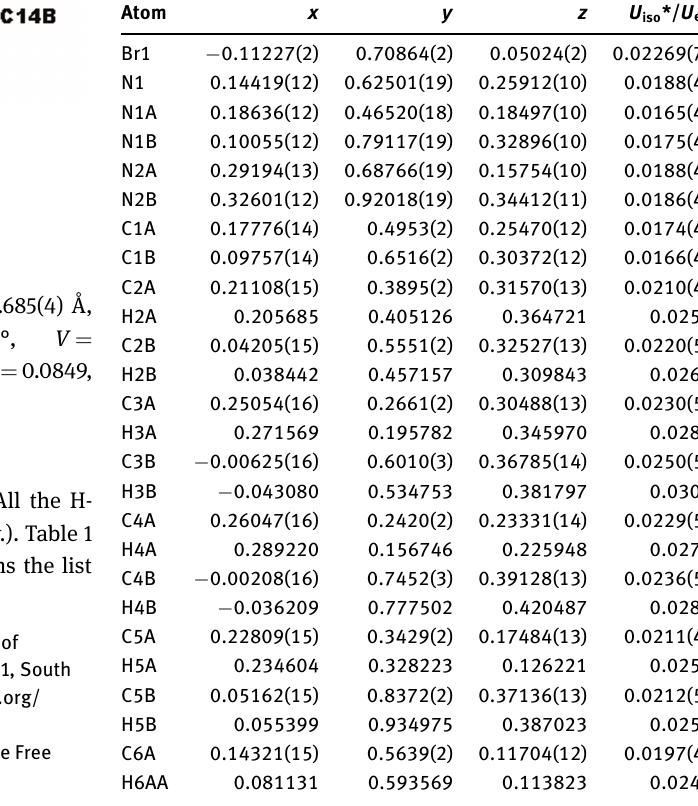
Table 2: Fractional atomic coordinates and isotropic or equivalent isotropic displacement parameters (Å 2